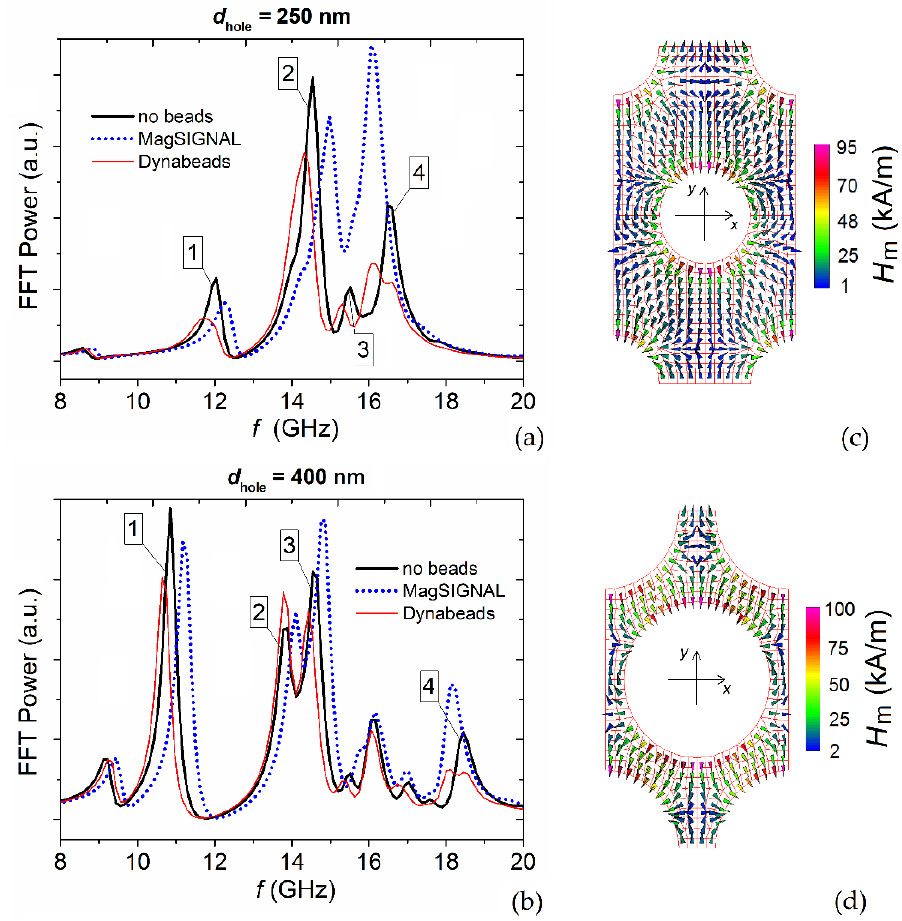
Figure 6. FFT power spectra of the average magnetization component along the excitation field direction ( x -axis) for a bias field of 150 kA/m parallel to the y -axis. The graph shows the FMR responses of the permalloy nanostructured film with ( a ) 250 nm and ( b ) 400 nm holes to the stray fields generated by MagSIGNAL-STA and Dynabeads MyOne beads trapped in the holes, assuming that the film surface is fully covered by beads. The case without beads is also reported for comparison. The numbers refer to the main modes in the spectra. Spatial distributions of the demagnetizing field in the unit cell of the permalloy nanostructured film with ( c ) 250 nm and ( d ) 400 nm holes.